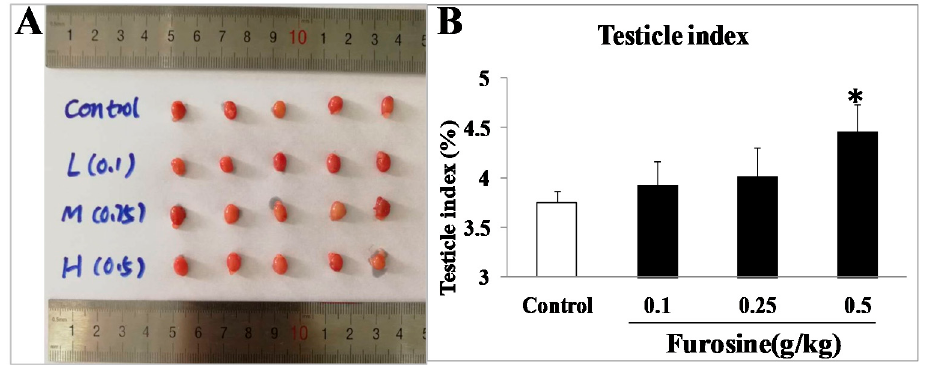
Figure 1. The effects of furosine on testicle index. ( A ) Mice testicles in each group. ( B ) Testicle index in each group. All the data were represented as mean ± SD, n = 8. * Comparing with the control, p ﹤ 0.05.